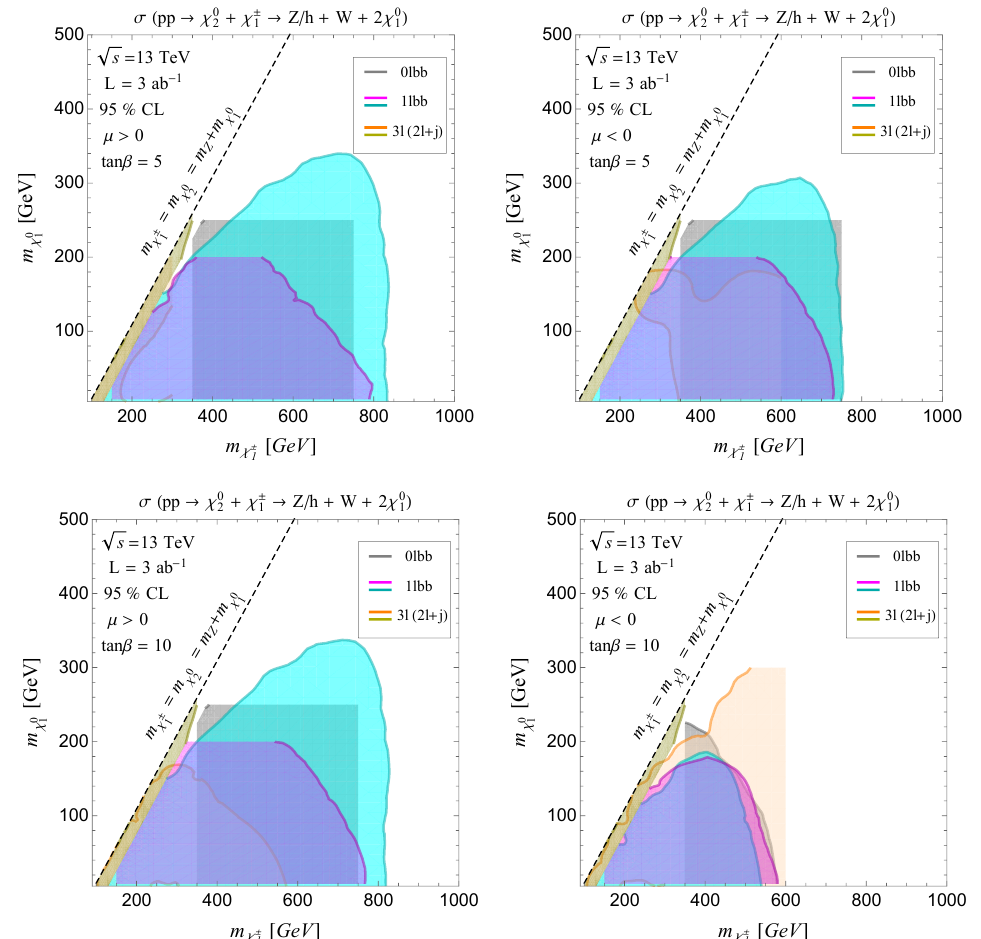
Figure 8 . 95% confidence level bounds on the Wino-Bino scenario projected for integrated lumi- nosity of L = 3 ab − 1 with M SUSY = | µ | = 2 TeV. The labels are similar to figure